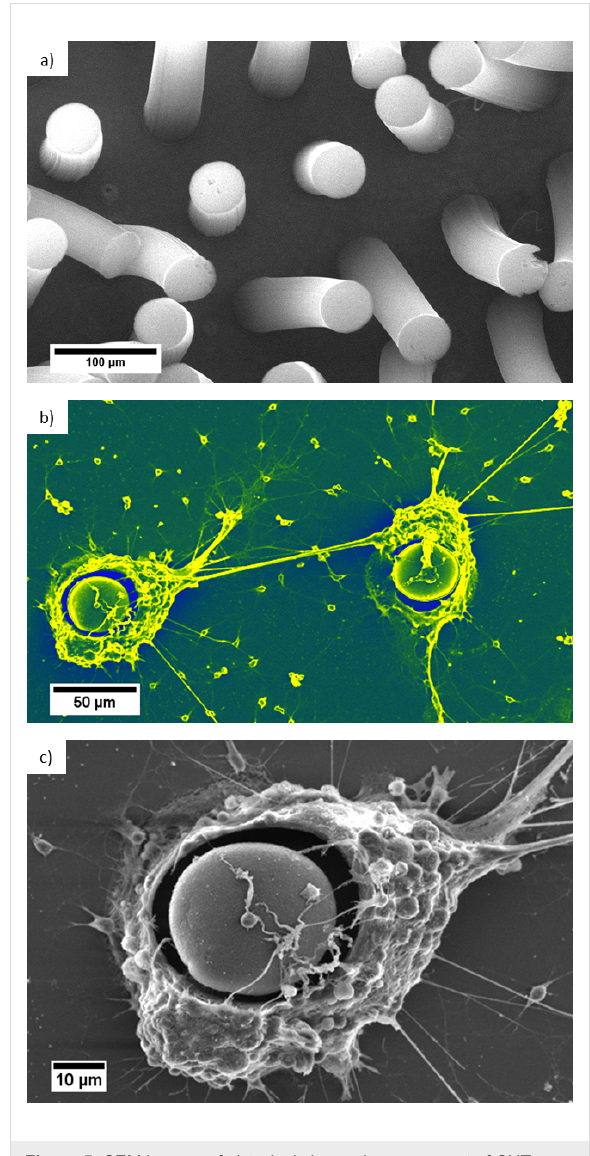
Figure 5: SEM images of a) typical size and arrangement of CNT pillars to be obtained by a WACVD process b) False colour image of two selected CNT pillar architectures with cultured cortical neurons (same dimensions as in Figure 3, height about 400 µm). Note: the dis- tance of the virgin CNT pillars in a) is 100 µm whereas in b) we have deliberately chosen for the neuron growth a substrate with a larger dis- tance of about 200 µm between individual CNT pillars to exemplify the strong attraction even over such macroscopic dimensions. c) Close up view of the vicinity of the vertical aligned CNT structure and the